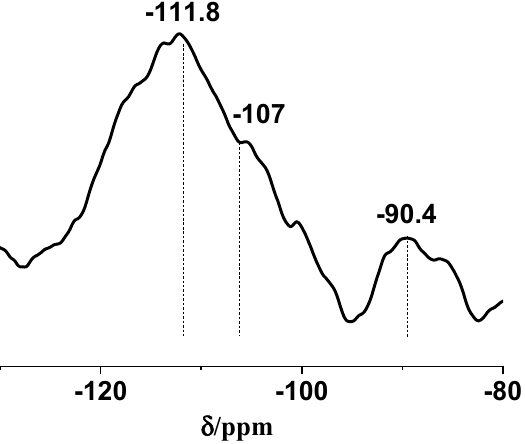
Figure 3. Fourier infrared spectrometer (FT-IR) spectra of SAPO-34 molecular sieves synthesized in different molar amounts of Si.